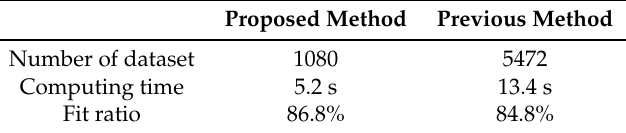
Figure 14. Robust stability analysis. Table 4. The comparison of some